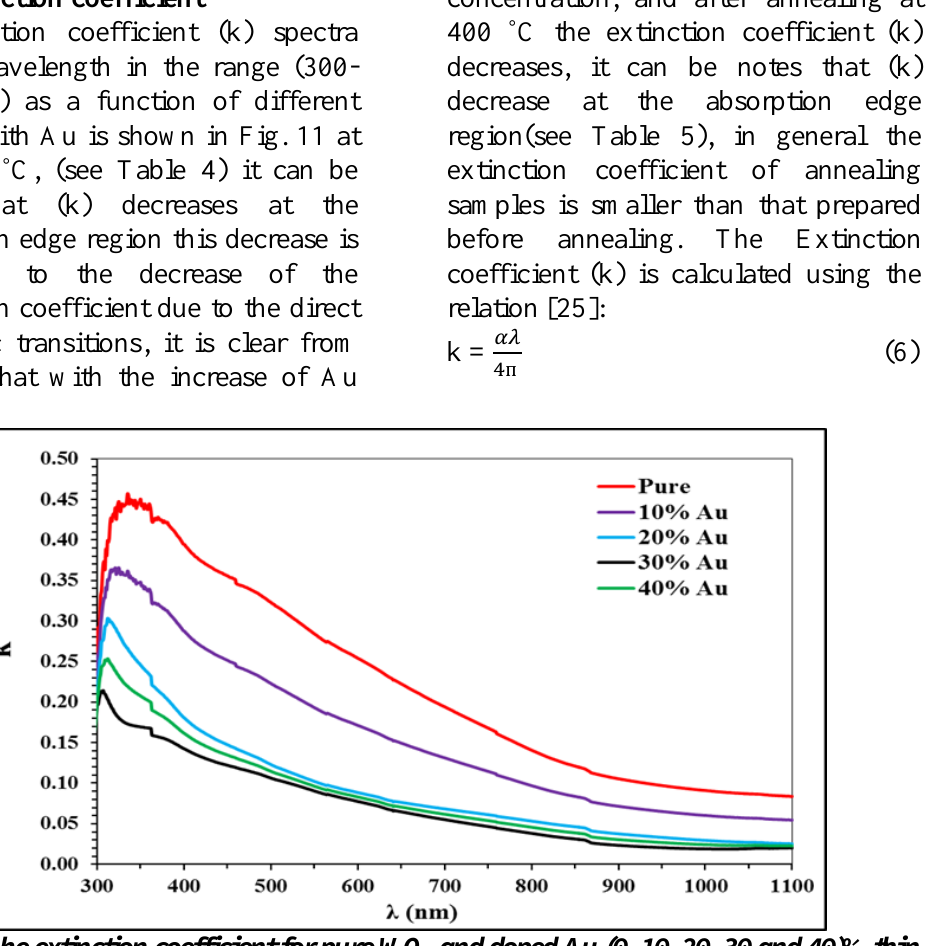
Fig. 11: The extinction coefficient for pure WO and doped Au (0, 10, 20, 30 and 40)% thin 3 films as a function of wavelength.